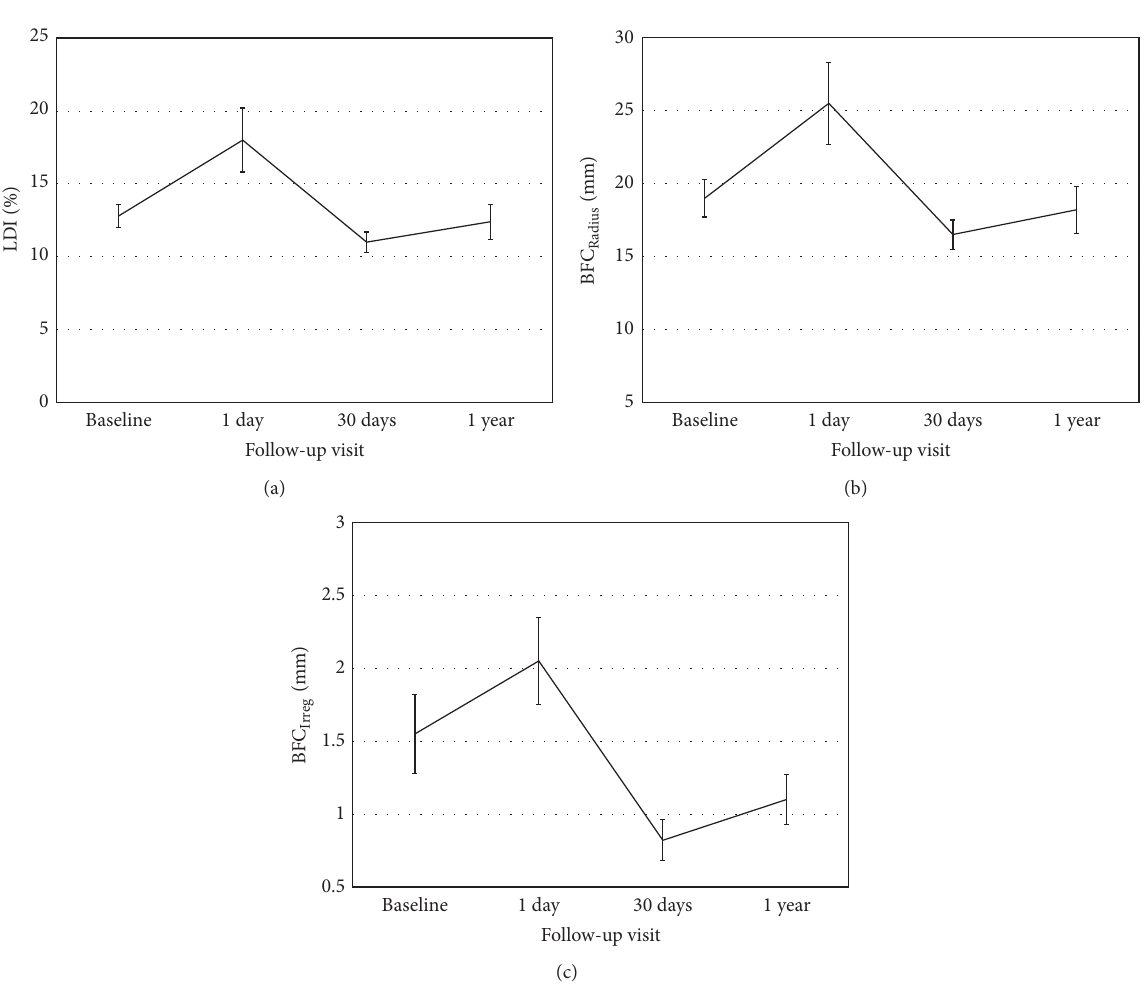
(b), and BFC (c) parameters. Error bars represent the standard error of the mean (SEM). Radius Irreg